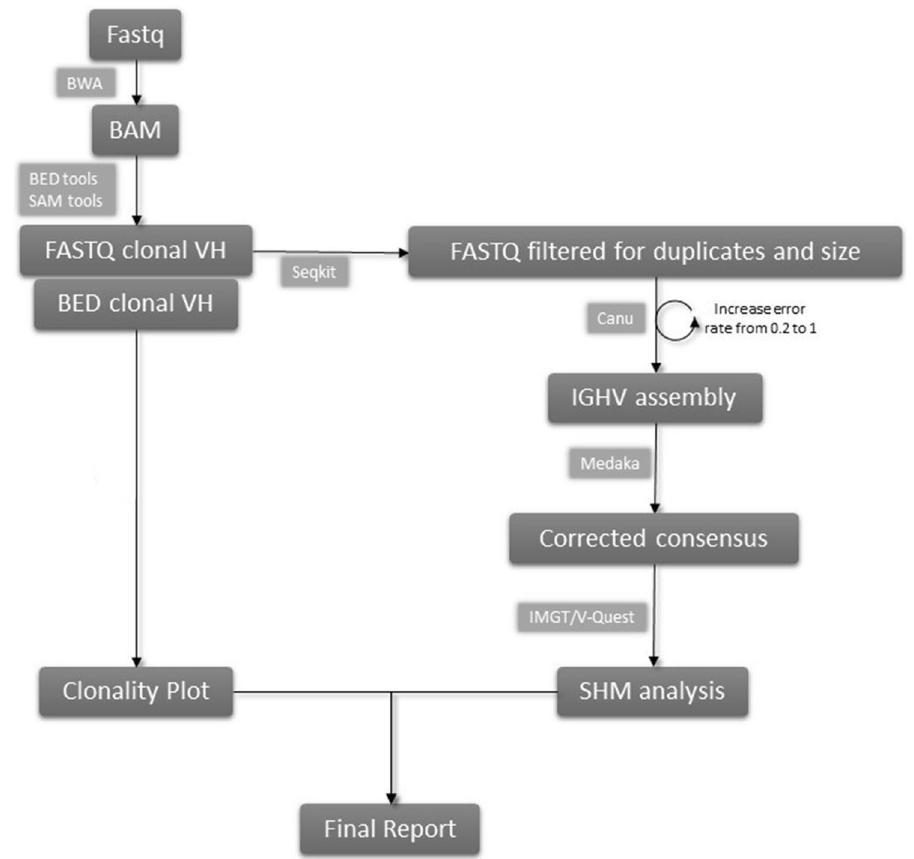
Figure 1. Schematic representation of the NanoIg